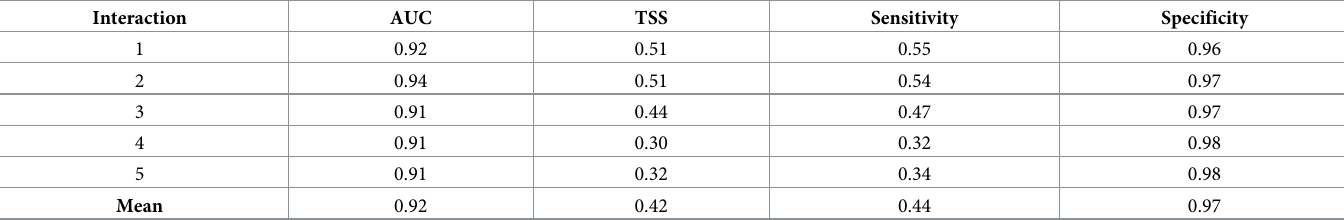
Table 3. Accuracy indices to evaluate the performance of the model for each interaction and the mean: Area Under the Curve (AUC), True Skill Statistic (TSS), Sen- sitivity and Specificity. Interaction AUC TSS Sensitivity Specificity